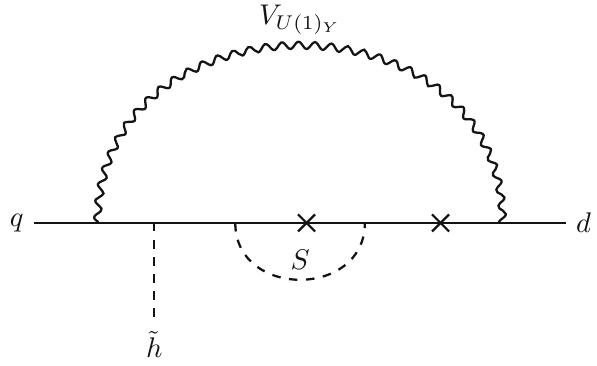
Fig. 3 Example of 2-loop diagram with heavy scalar